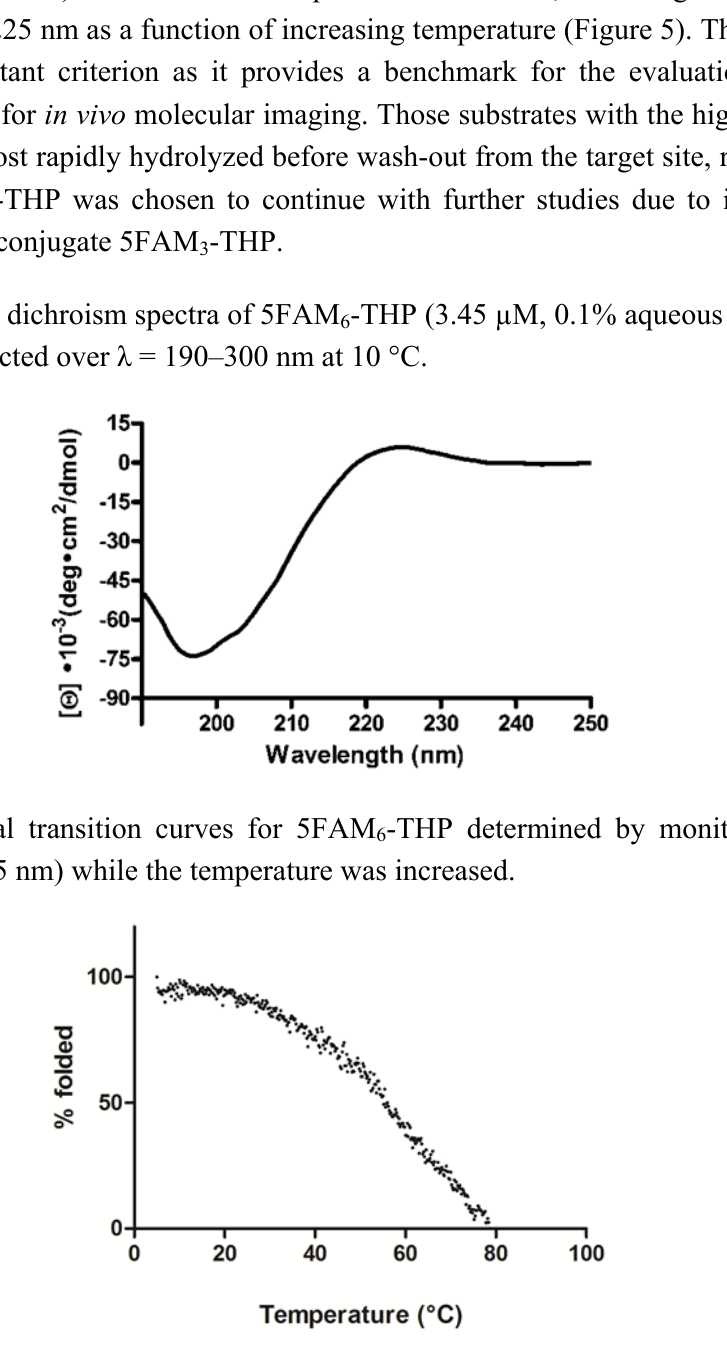
-THP (3.45 µM, 0.1% aqueous acetic acid). 6